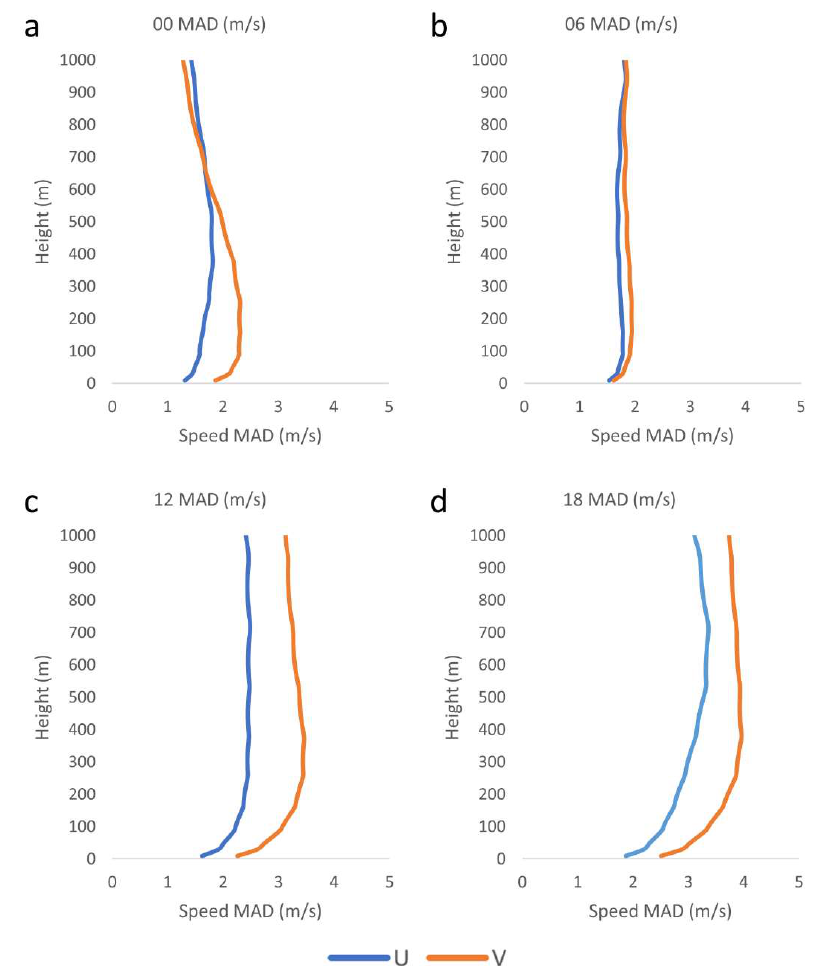
Figure 11. Vertical distribution of mean absolute difference (MAD) of U (m/s) and V (m/s) between Test 1 and Test 2 in 00 UTC ( a ) 06 UTC ( b ) 12 UTC ( c ), and 18 UTC ( d ).